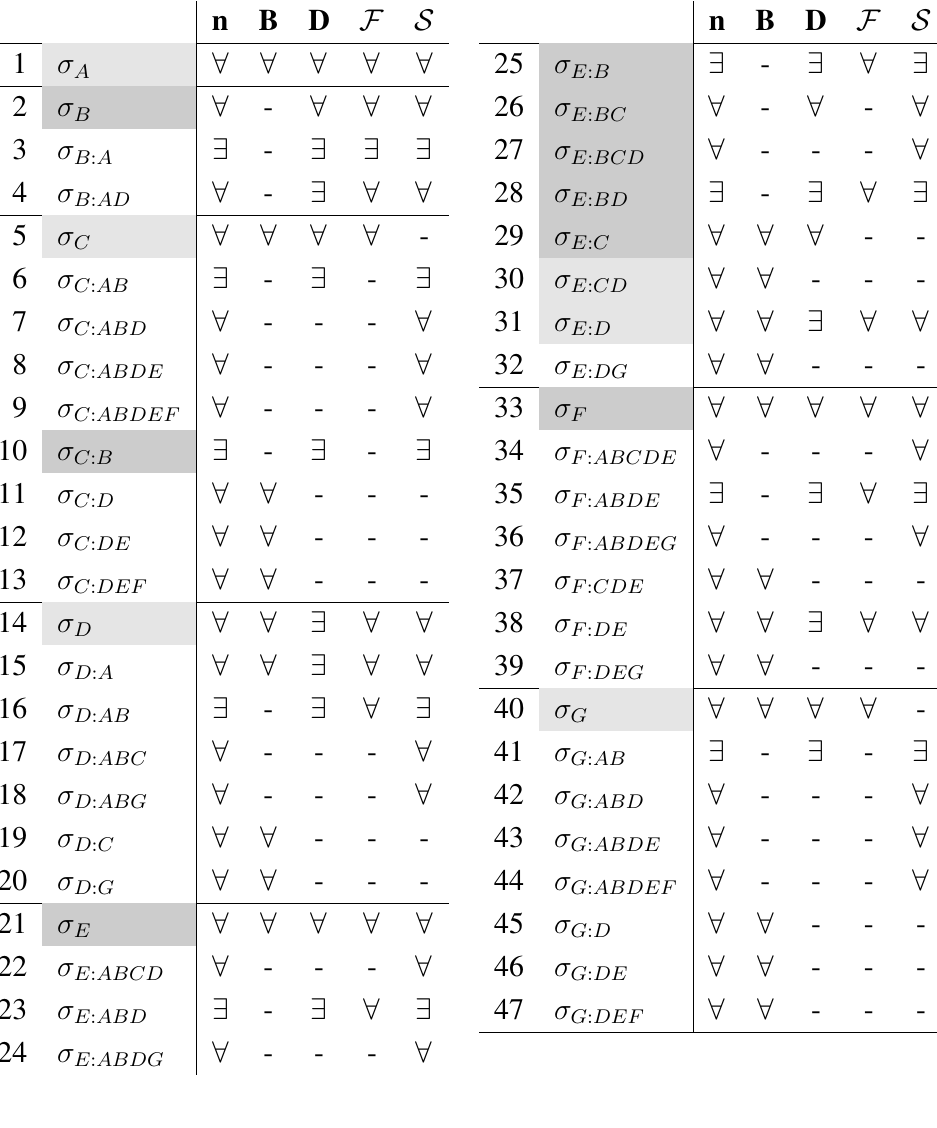
Figure 10. Specifications that operation B cannot be reexecuted and that operation K can be reexecuted at most two times.